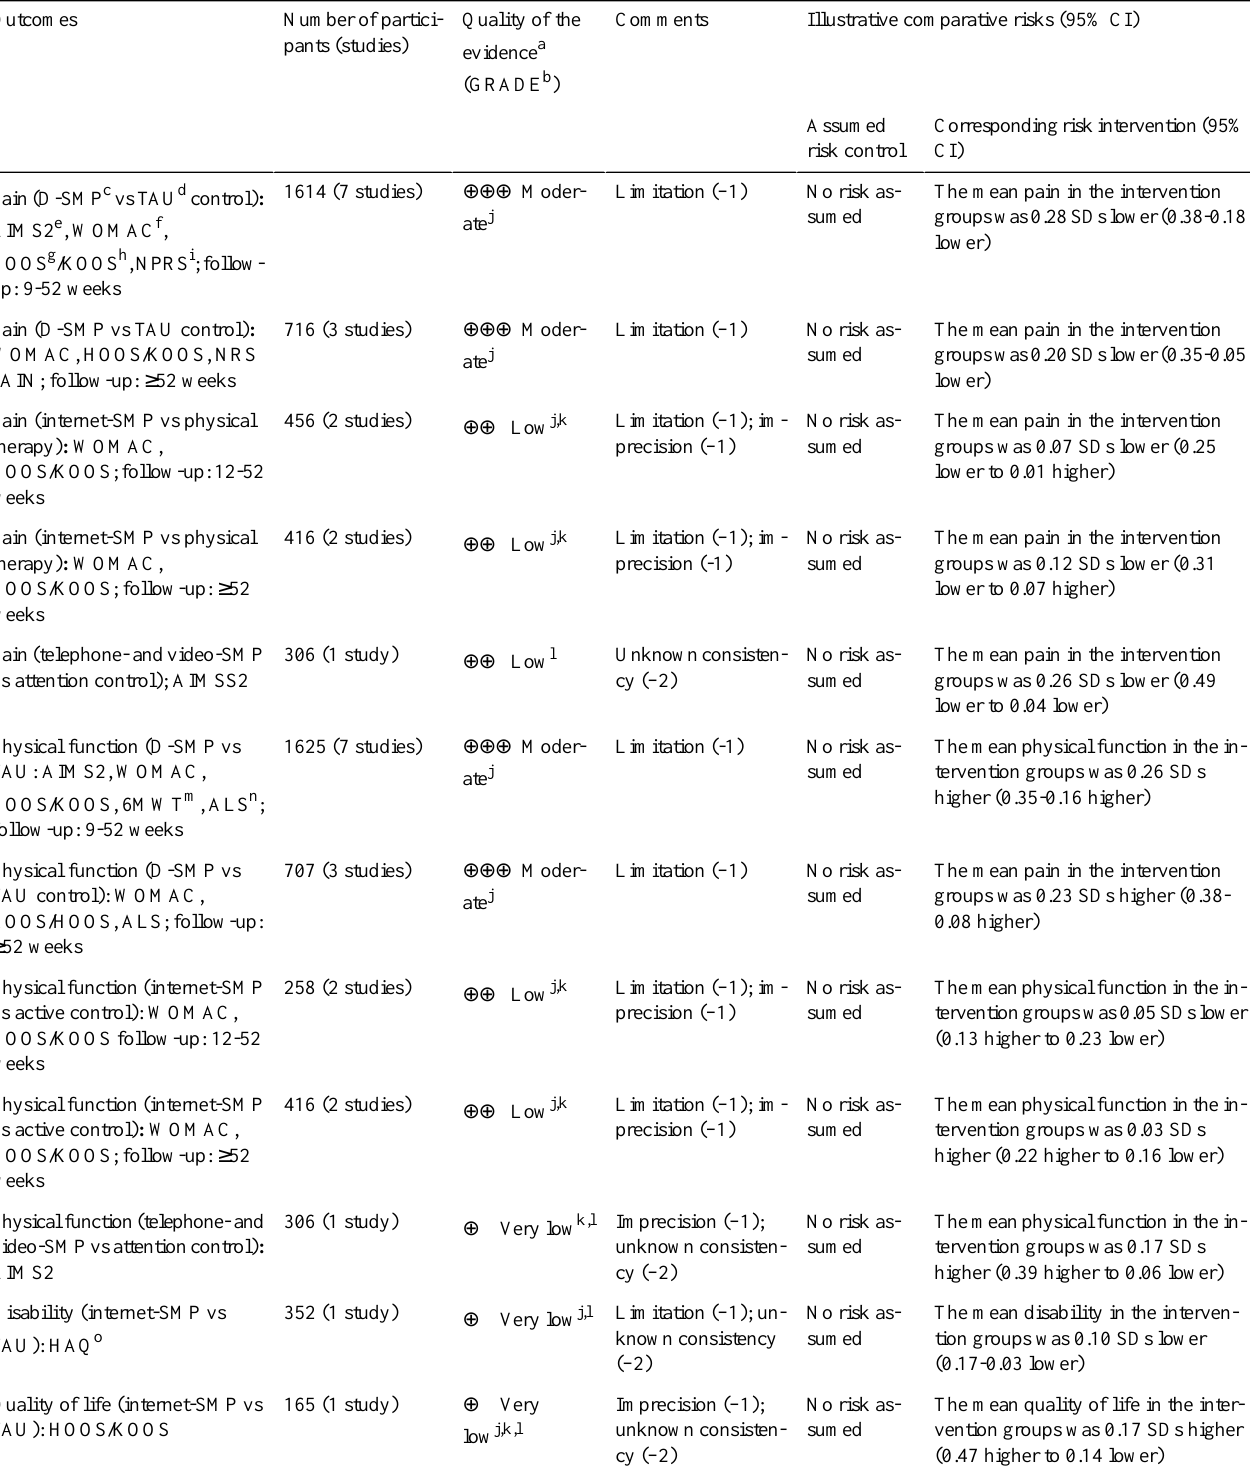
Table 7. Summary of findings and Grading of Recommendations, Assessment, Development, and Evaluations ratings for the main